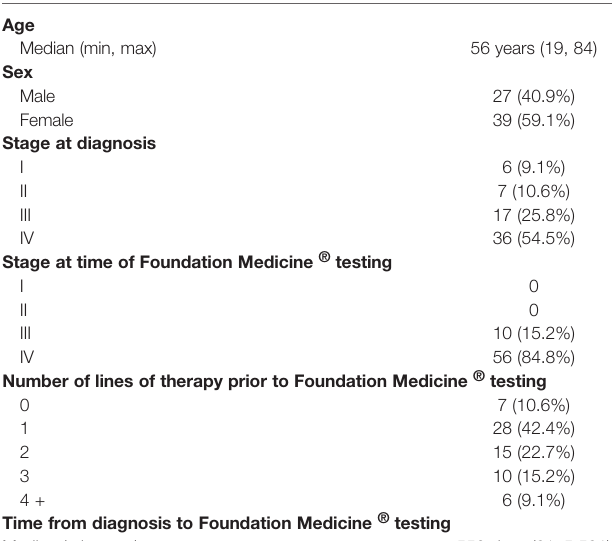
TABLE 1 | Patient demographic data.